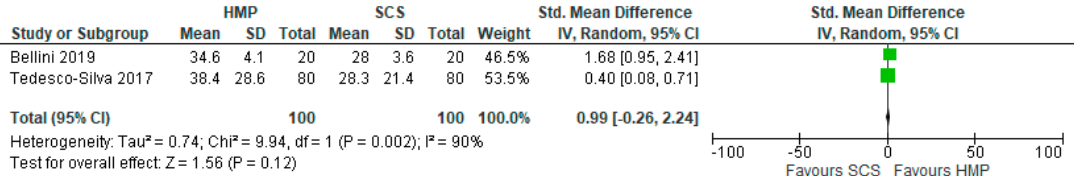
Figure 8. Estimated glomerular filtration rate (eGFR) in kidneys preserved via HMP and SCS; eGFR day 7.